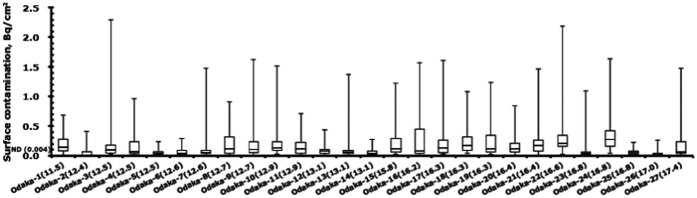
Values of surface contamination for 27 houses in Odaka district, shown as a box plot in order of their distance from the FDNPP.Number in parenthesis in the measurement’s name represents each distance (km) between the house and the FDNPP.